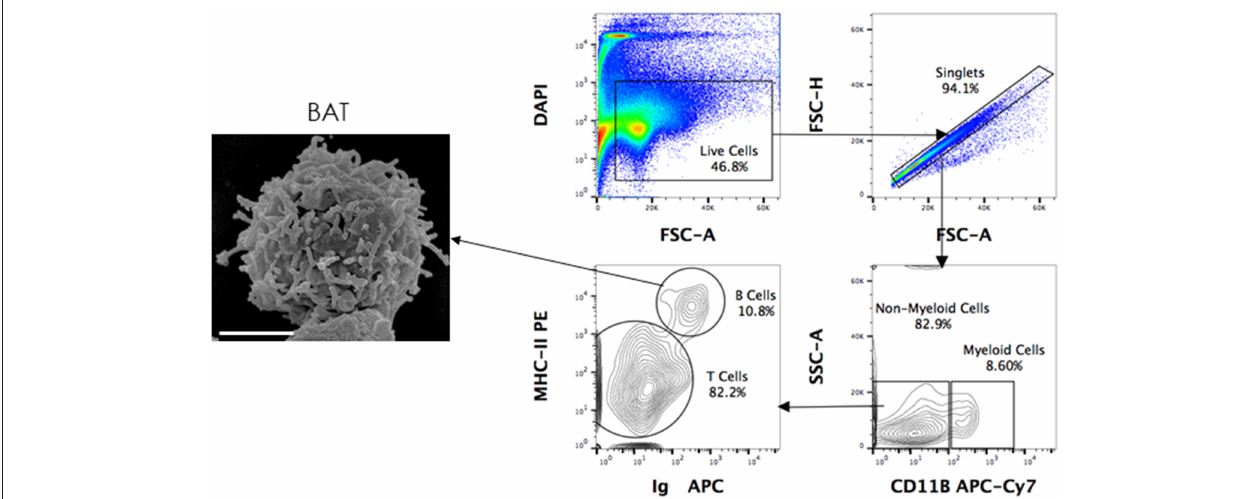
FIGURE 3 | Scanning electron microscopy (SEM) of FACS sorted B cells. P. alecto splenocytes were surface-stained for CD11b, MHC-II and Ig antibodies and sorted as CD11b − MHC-II + sIg + (B cells), CD11b + (myeloid cells) and CD11b − MHC-II − sIg − cells (T cells). Sorted B cells were processed for viewing under a scanning